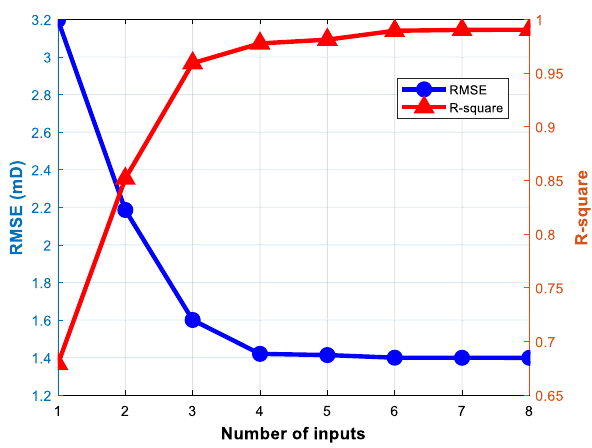
Fig. 7 Variations of error and R 2 for modeling the permeability with the help of MLP with the optimum sets of features considering vari- ous counts of input features to the NSGA-II in the first and second layers, respectively. Accordingly, the MLP with this structure was combined with NSGA-II to come up with a hybrid model for feature selection. Table 4 The best sets of No. of fea- Input feature RMSE features for modeling the tures permeability for various counts of input features to the NSGA-II (the selected set of features for modeling is bolded)